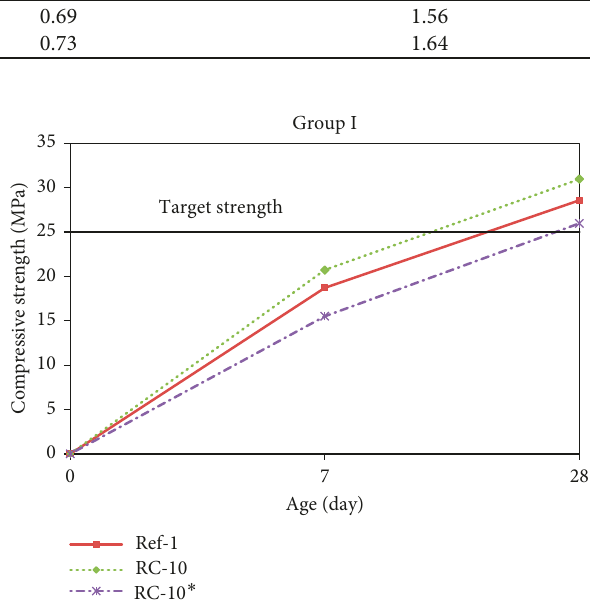
Figure 3: Compressive strength of the concrete specimens cate- gorized in Group I.